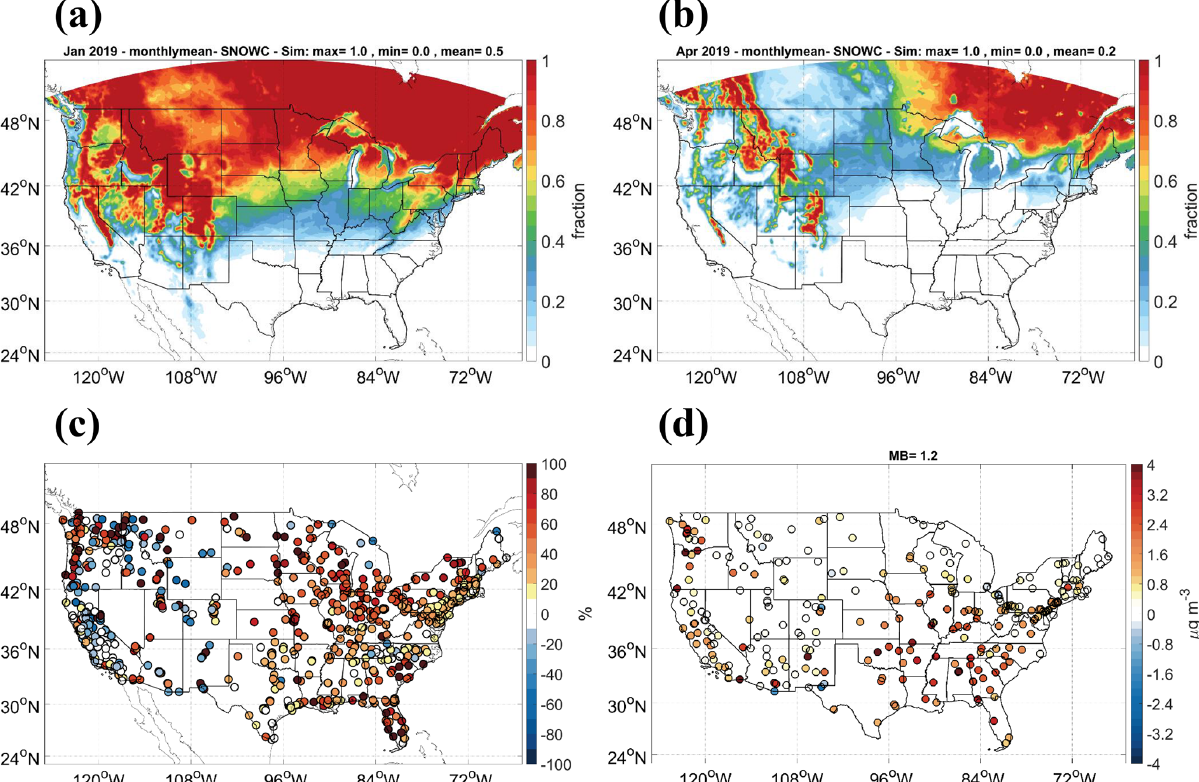
Figure 7. The predicted average snow cover for (a) January and (b) April. (c) The difference in NMBs of PM 2 . 5 by adjusting PM emission for January. Positive values stand for improvement in biases with NMBs closer to 0. (d) MBs in PM 2 . 5 soil composition with adjustment of PM emission for